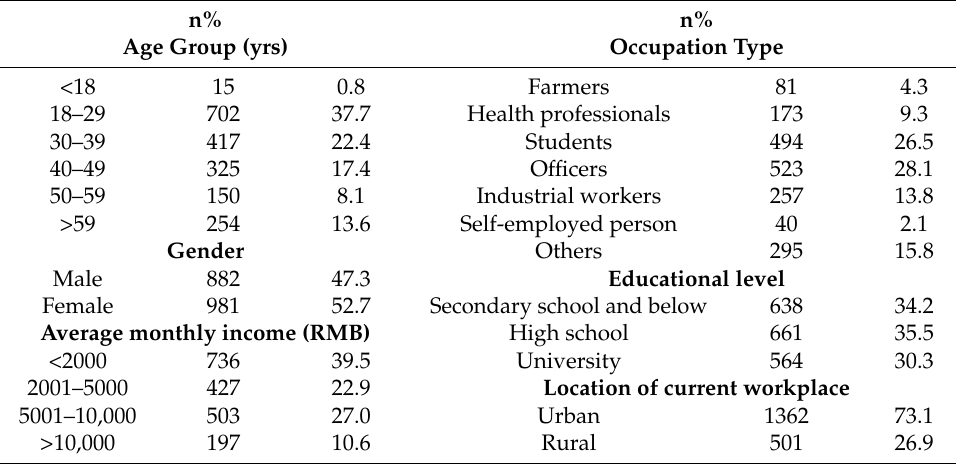
Table 1. Participant characteristics (N =